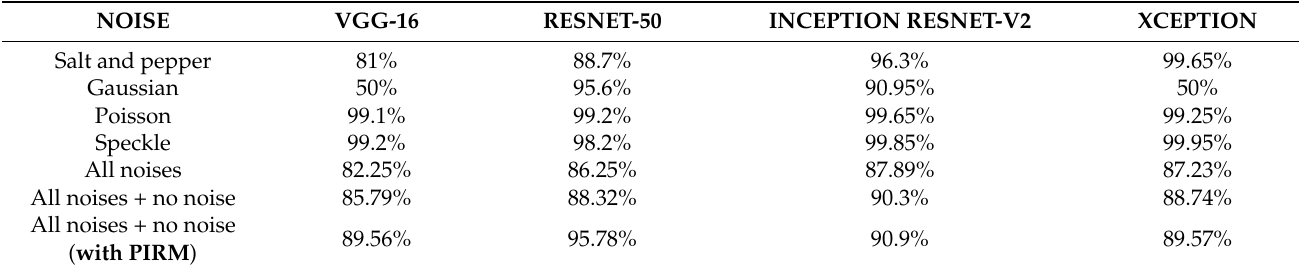
Table 4. Accuracy of various models using proposed